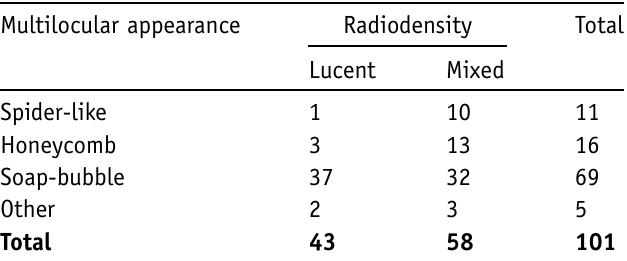
Table III. Comparison of multilocular appearance and radio- density on